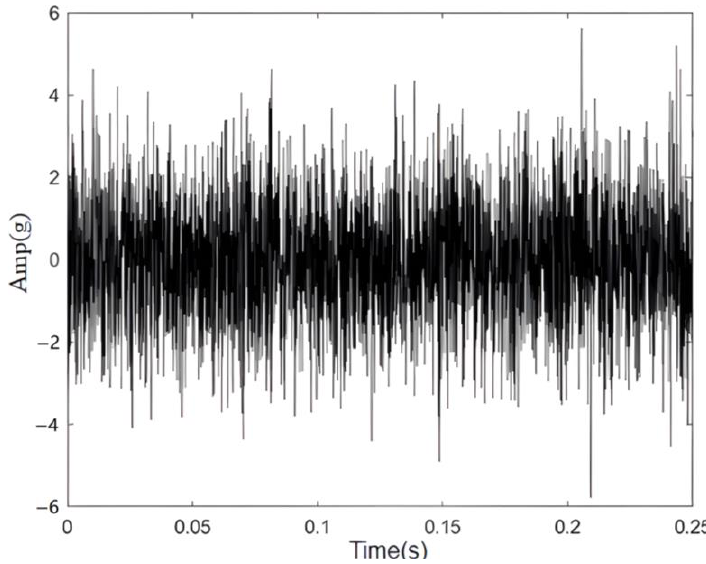
Figure 3. Time Domain Diagram of Outer Ring Fault Signal with Strong Noise.